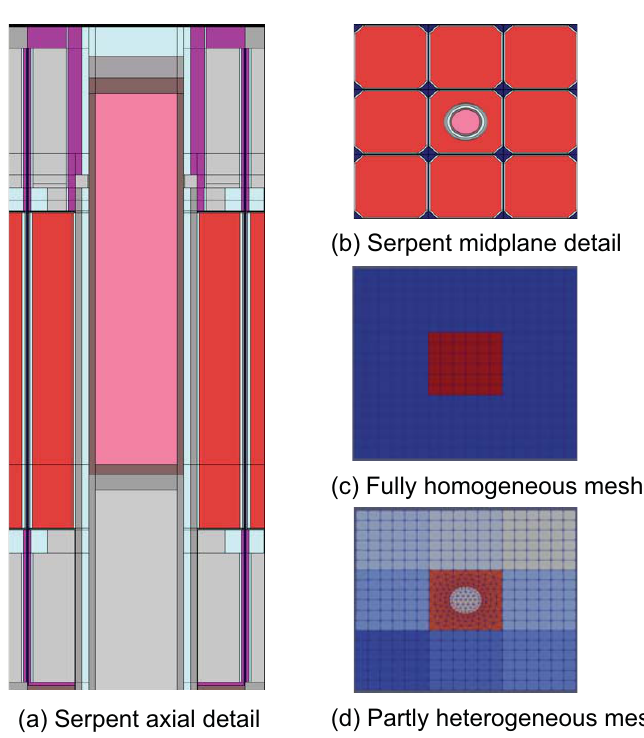
Figure 4: TREAT transient control rod